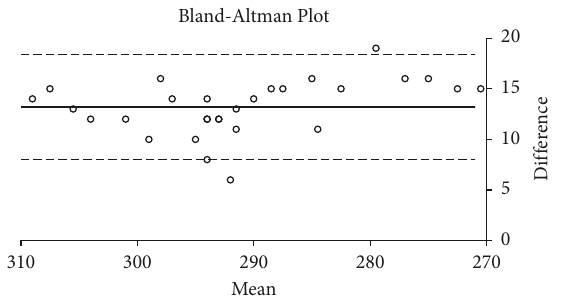
Figure 6: Bland–Altman plot for the correlation between tear osmolarity measurements taken using the TearLab and I-Pen systems in the control (non-smokers)